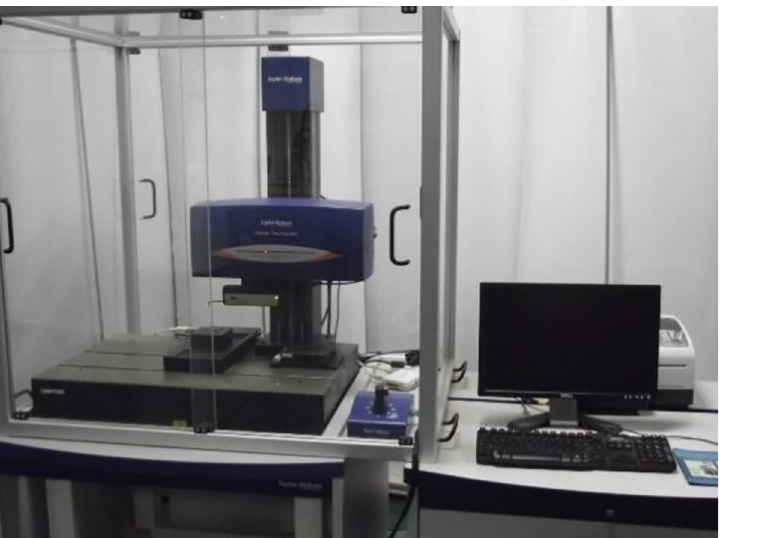
Fig 1. Surface morphology instrument